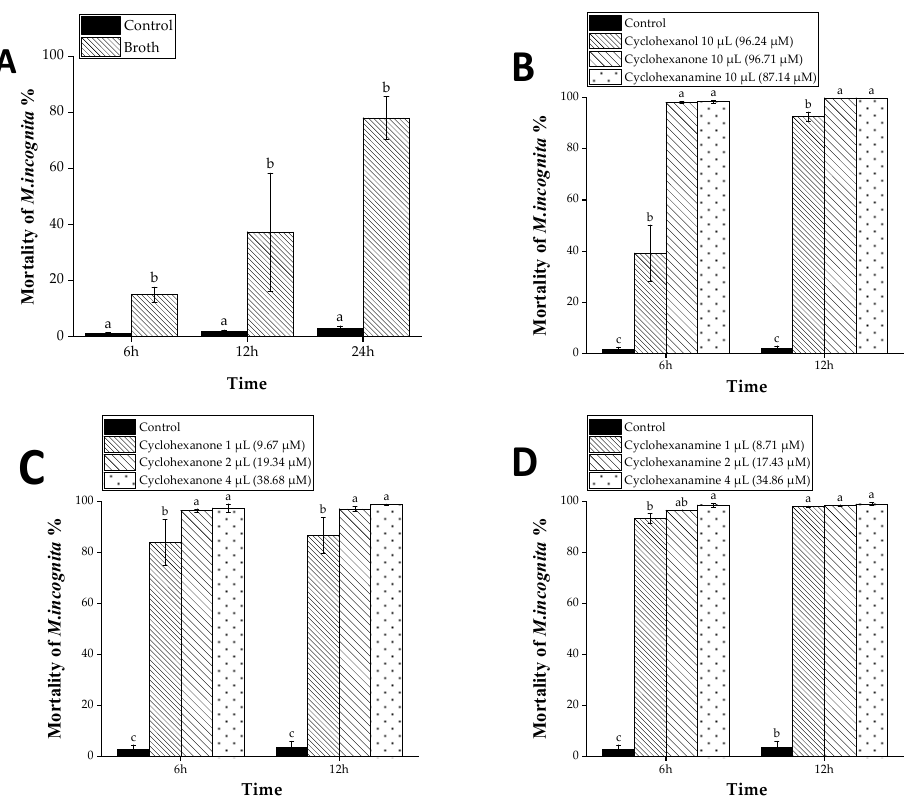
Figure 3. Nematicidal activity of VOCs produced by D. flagrans against M. incognita . Values with the same lowercase letters in the figure have no difference when p < 0.05; bars indicate the standard error of the means ( n = 3). ( A ) The mortality of nematodes treated with broth and control; ( B ) The mortality of nematodes treated with cyclohexanol, cyclohexanone and cyclohexanamine; ( C ) The mortality of nematodes treated with different doses of cyclohexanone; ( D ) The mortality of nematodes treated with different doses of cyclohexanamine.